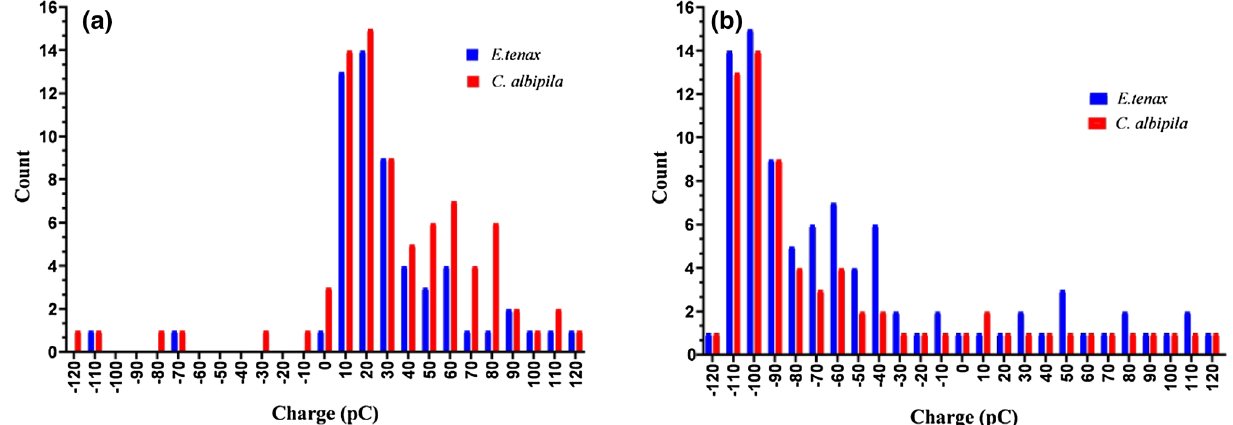
Figure 1. The electric charge carried by both species and it’s transfer to artificially prepared flowers. The histogram of charge carried by flying hoverfly species; measured by the Faraday pail instrument. ( a ) Cheilosia albipila carried a relatively higher charge than the Eristalis tenax and charge (pC) changes into positive when the flies enter into the Faraday pail and shouts up when it touches the flowers. ( b ) Indicates the net opposite charge on both species after removing thoracic hairs. It shows that both the species have a net negative charge (pC) on their bodies after removing the